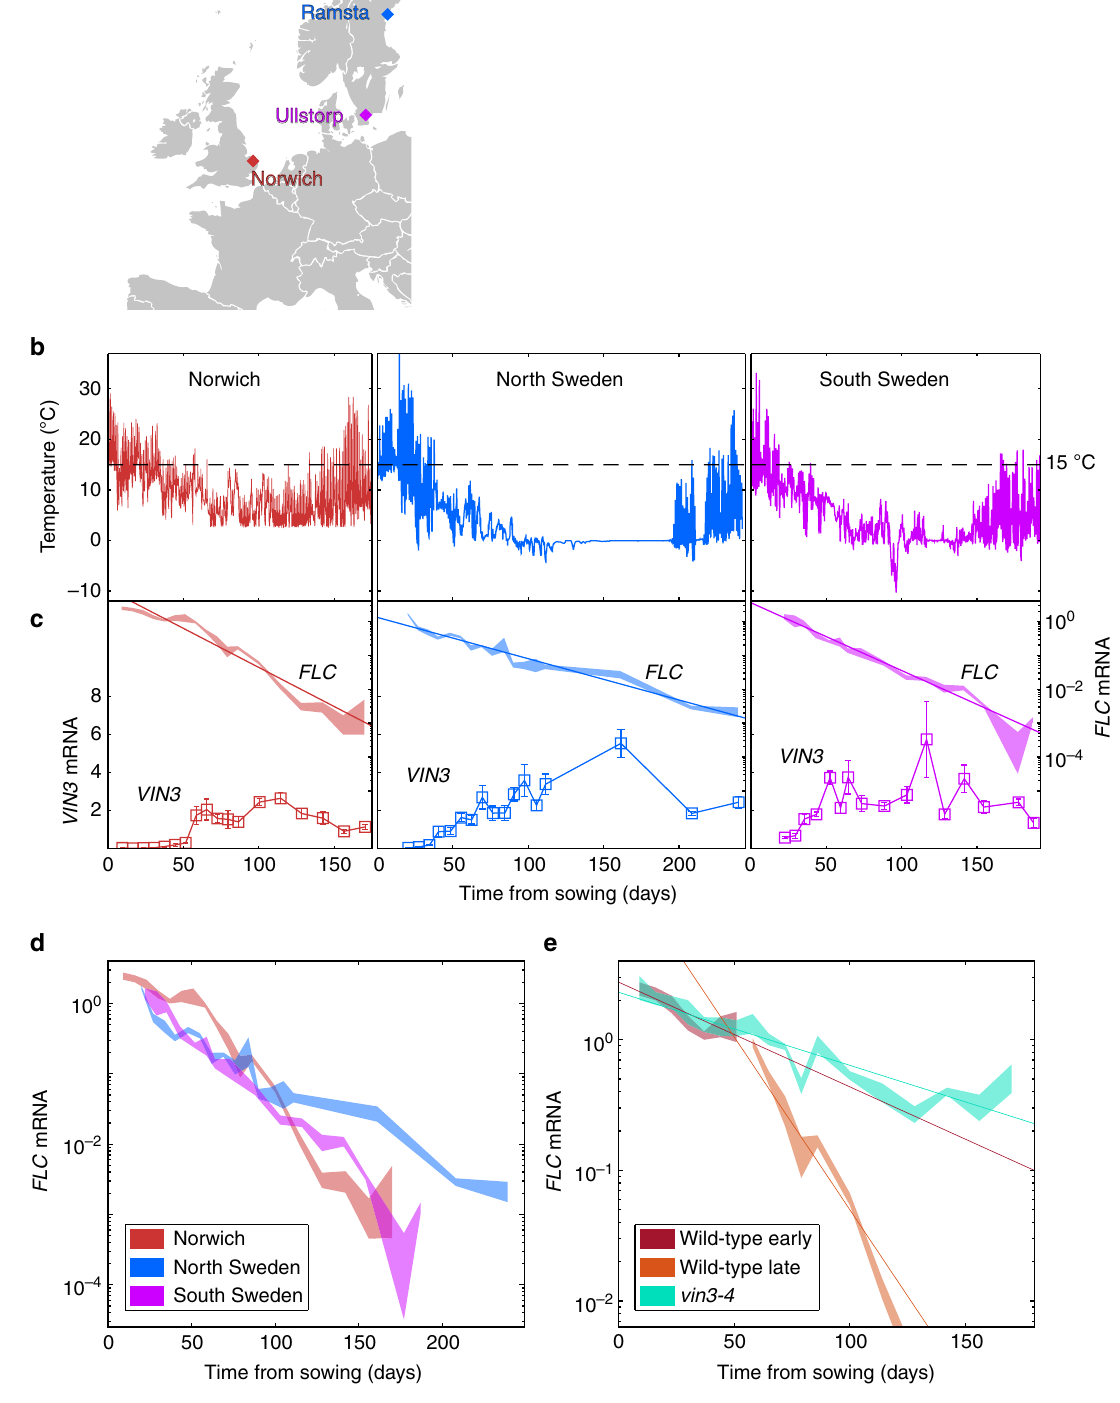
Fig. 1 FLC downregulation occurs in the fi eld in both VIN3-independent and dependent manners. a Locations of fi eld sites in Norwich, North Sweden (Ramsta) and South Sweden (Ullstorp). b Temperatures experienced by the plants in the different sites. Dashed line indicates 15 °C. In Norwich, glasshouse con fi nement is probably responsible for buffering low temperatures (see Methods). c FLC and VIN3 expression for Col FRI SF2 , as measured in the fi eld corresponding to plot above. FLC (top): Thick lines show measured FLC mRNA where c − e thickness of the line represents s.e.m. VIN3 (below): measured expression of VIN3 mRNA, errors = s.e.m. d Comparison of FLC downregulation between different sites. e FLC downregulation in Norwich for ‘ wild-type ’ (Col FRI SF2 ) and a mutant impaired in VIN3 expression ( vin3-4 FRI ). For the wild-type, the data are separated according to presence (late timepoints) or absence (early timepoints) of VIN3 expression, as measured in panel c . RNA levels in c − e normalised to UBC , PP2A , and internal control. Straight lines ( c , e ) show the best fi t exponential decay pro fi le, fi tted by least-squares. n = 2 – 6, average ≥ 5. Map adapted from https://commons.wikimedia.org/wiki/File: Blank_map_of_Europe.svg by maix, under CC BY-SA 2.5